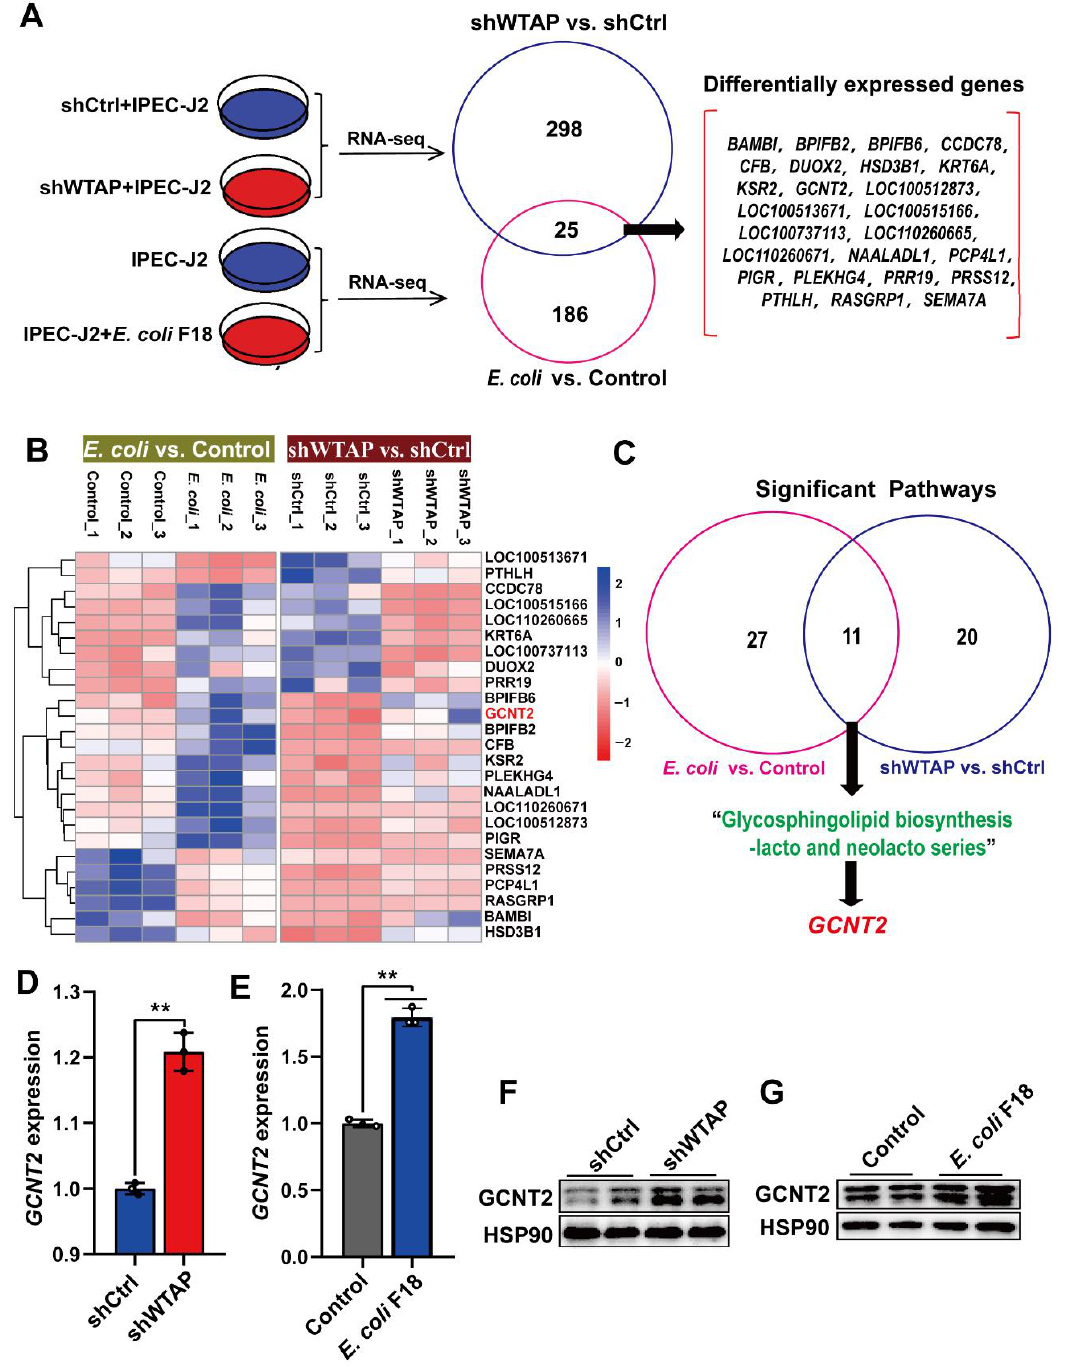
Figure 3. Transcriptome sequencing identified GCNT2 as a WTAP downstream target. ( A ) Venny analysis of differentially expressed genes (DEGs) in IPEC-J2 from shWTAP and shCtrl group, E. coli and Control group by comparative transcriptome sequencing. ( B ) Hierarchical clustering analysis of common DEGs between shWTAP vs. shCtrl and E. coli vs. Control. ( C ) Venny analysis of significant pathways that DEGs were involved in. ( D ) qPCR analysis of GCNT2 expression in IPEC-J2 cells transfected with control and shWTAP vector. ( E ) qPCR analysis of the expression change of GCNT2 in IPEC-J2 cells after E. coli F18 infection. ( F , G ) Western blotting analysis of GACN2 expression in IPEC-J2 cells after WTAP knockdown or E. coli F18 infection. All data are presented as the mean ± SD, ** p < 0.01.